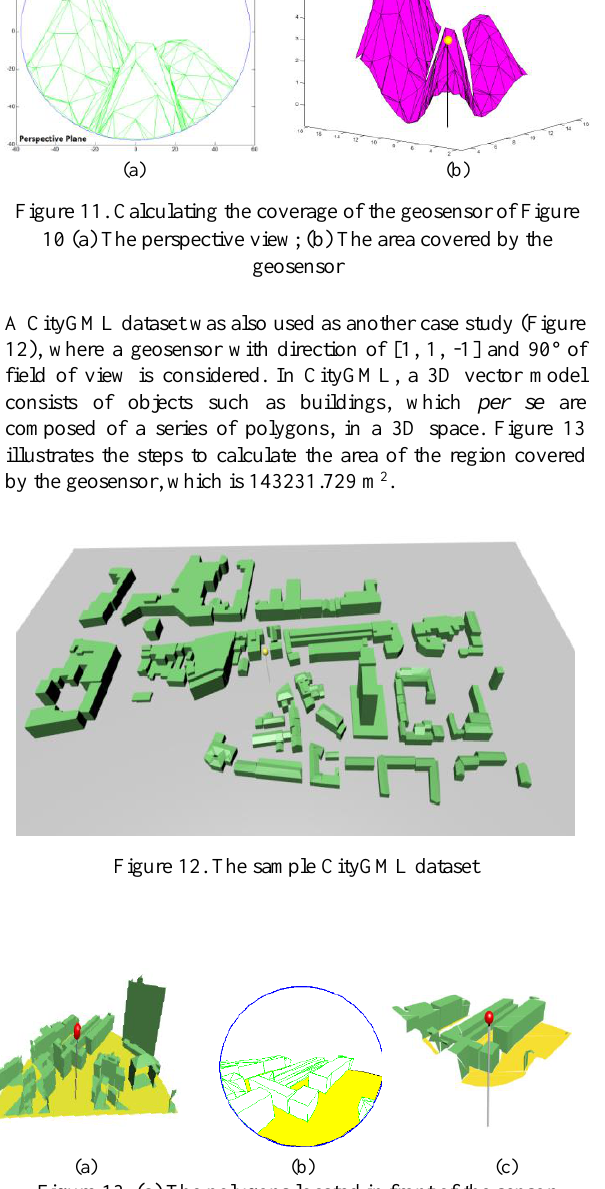
Figure 16. DSM model of the spatial resolution of (a) 2m; (b) Figure 13. (a) The polygons located in front of the sensor 0.2m and within its sensing range; (b) The perspective view of the polygons visible by the sensor; (c) 3D polygons visible by the sensor